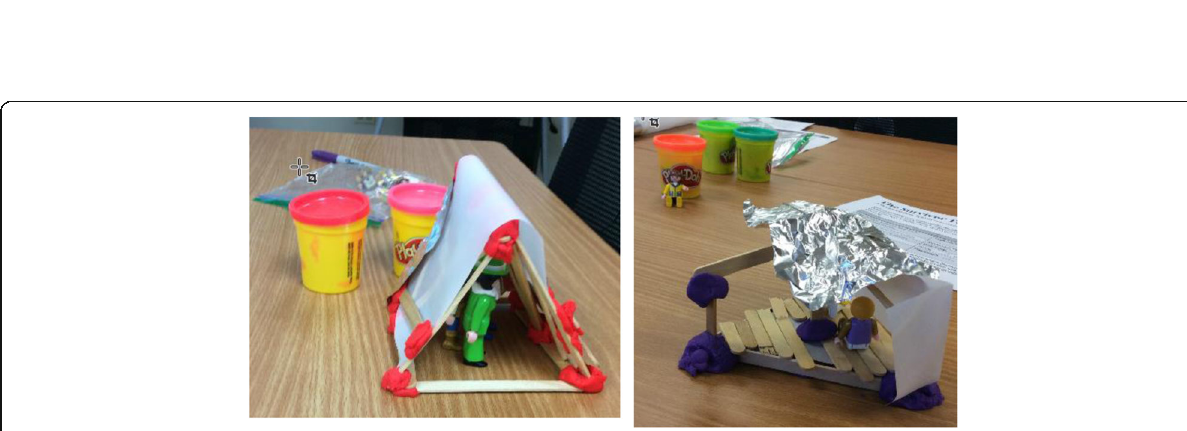
Fig. 2 Survivor MEA — physical models of water-resistant